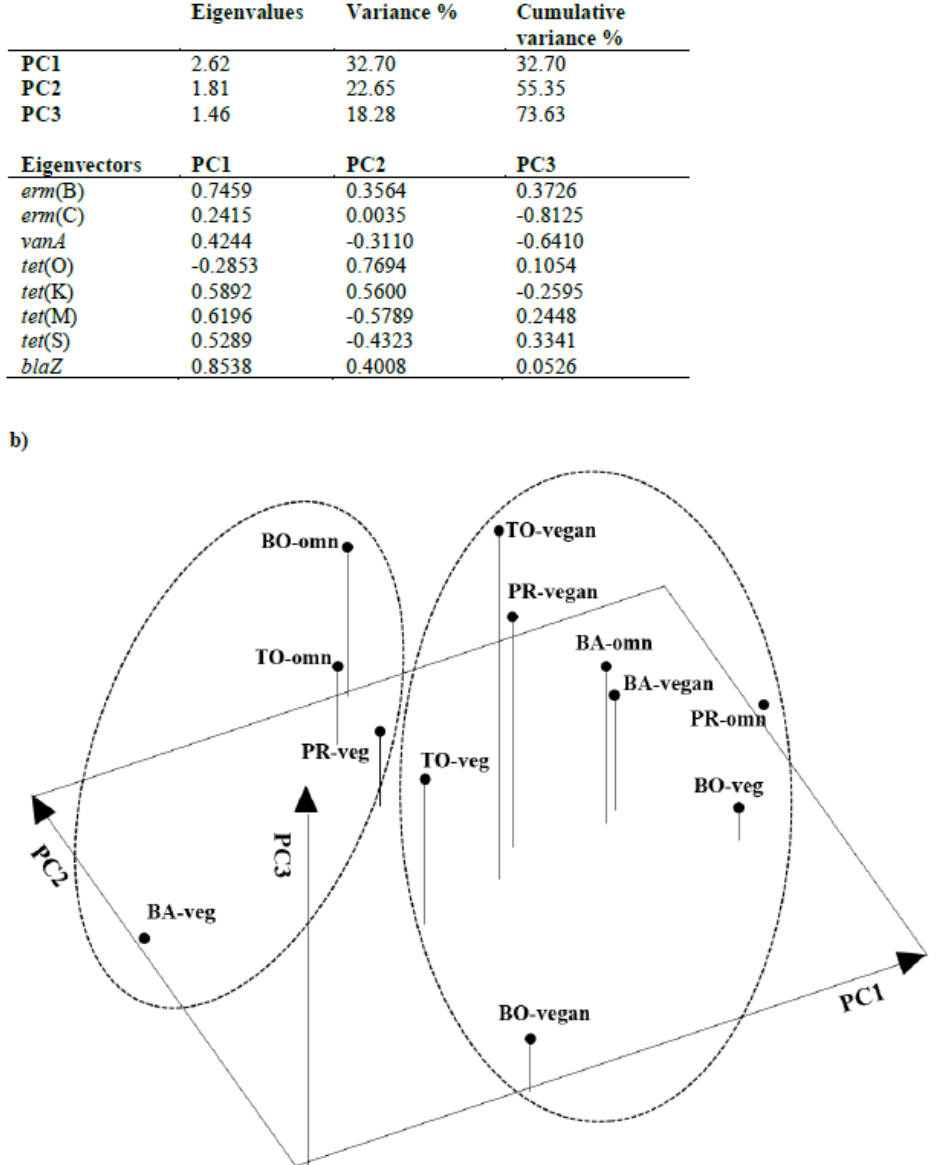
Figure 3. Principal Component Analysis (PCA) results: panel ( a ) eigenvalues, percentage of variance explained and eigenvectors of the principal components; panel ( b ) PCA three-dimensional plot. BA, Bari; BO, Bologna; PR, Parma; TO, Turin; omn, omnivores; veg, ovo-lacto vegetarians.